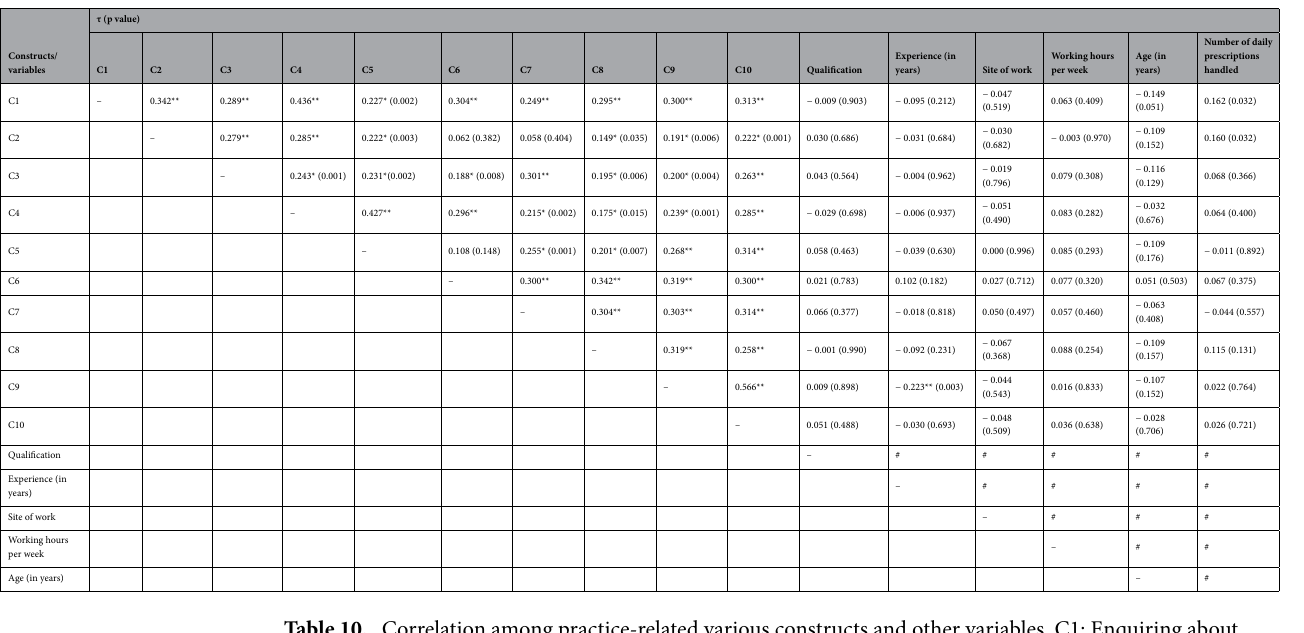
Table 10. Correlation among practice-related various constructs and other variables. C1: Enquiring about and reviewing patient’s medical and medicine records to decide if any intervention or recommendation